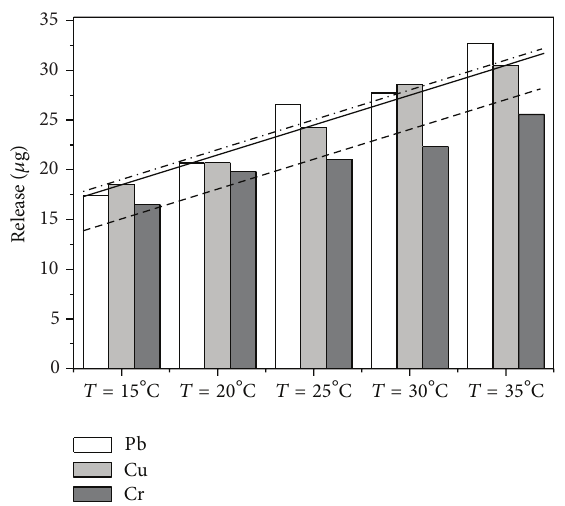
Figure 7: The relationship between the maximum amount of accu- mulated release of Cu, Pb, and Cr from sediment in experimental period and